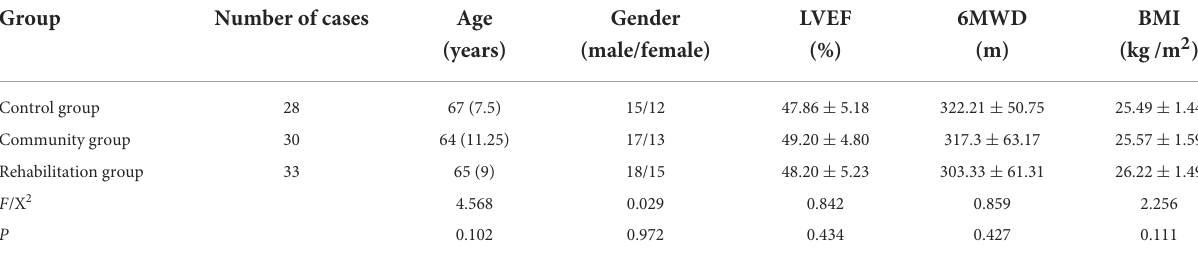
TABLE 1 Demographics of patients in three groups ( ¯ x ± s).